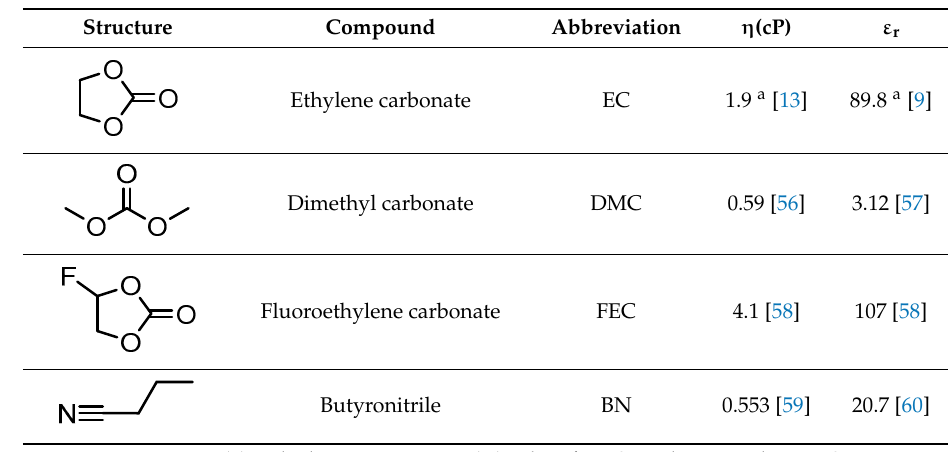
Figure 6. Cycling profiles ( a ) and Coulombic e ffi ciencies ( b ) of NMC / graphite cells containing 1M LiPF 6 in BN:EC (9:1) + 3% FEC as well as 1M LiPF 6 in EC:DMC (1:1), respectively as electrolyte, cycled in the voltage range of 3.00–4.30 V. Table 1. Summary of solvents used in this work. Physical properties are reported at 25 °C if not stated otherwise [55]. Table 2. Selected specific discharge capacities for the cells cycled with the BN-based electrolyte (cell a) and 1M LiPF 6 in EC:DMC (1:1) (cell b), respectively.